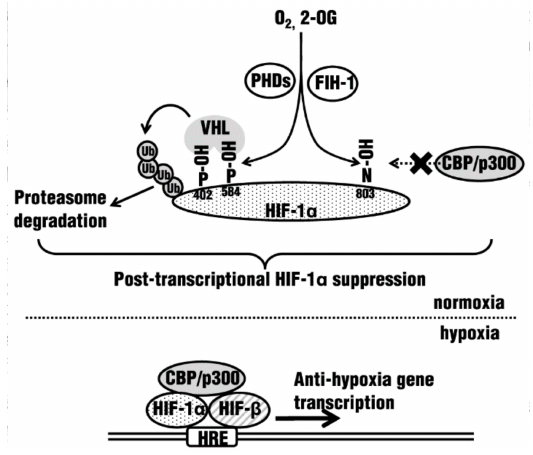
Figure 1. Regulatory mechanisms mediating the HIF-related